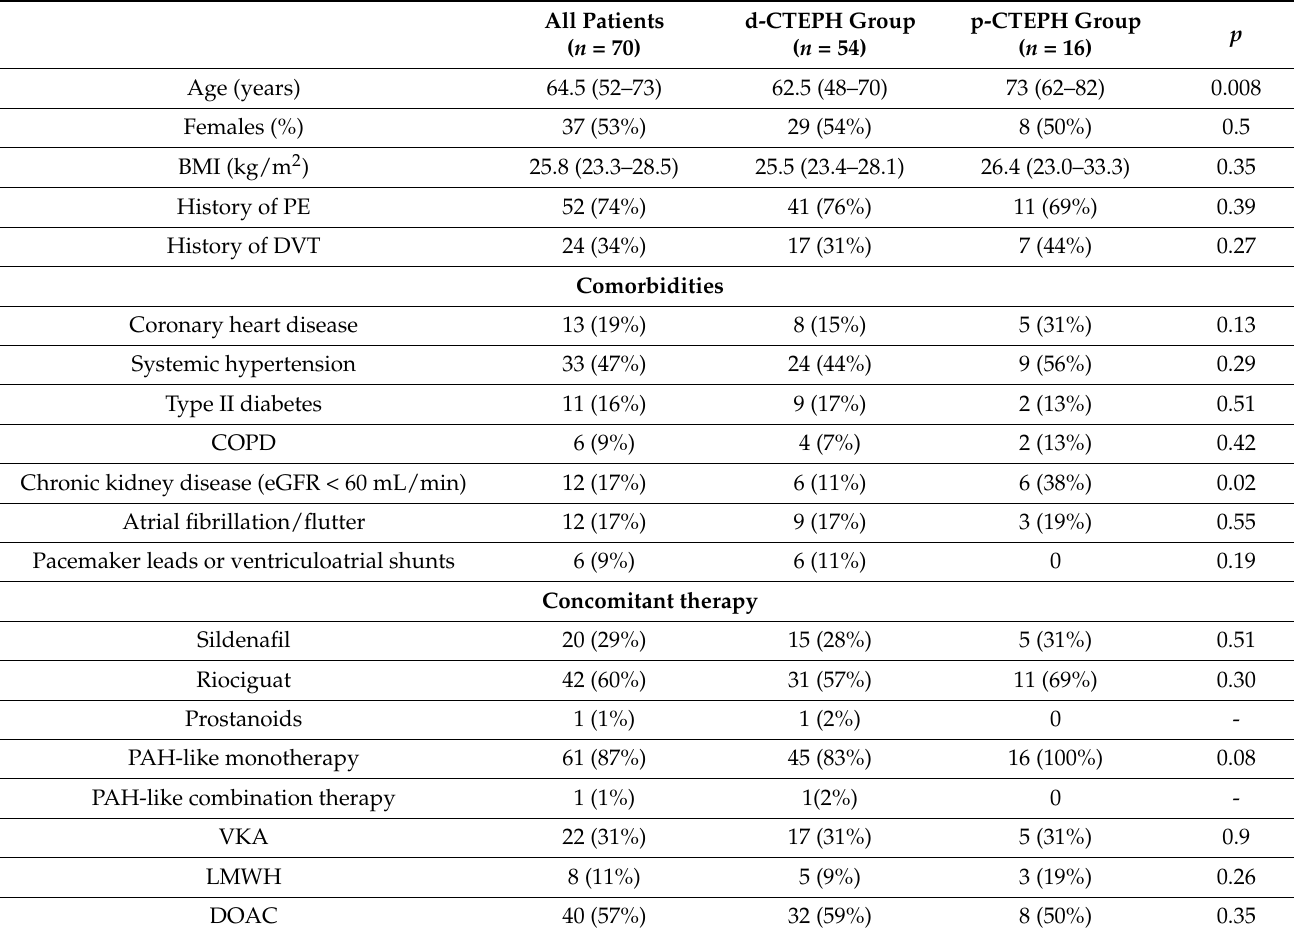
Table 1. Clinical characteristics of the studied